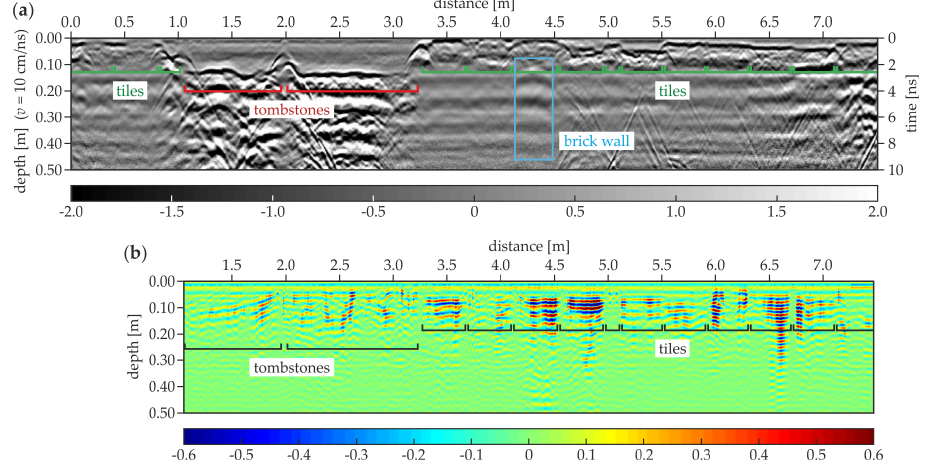
Figure 19. GPR and UT B ‐ scans for trace A ‐ 129 (south aisle): ( a ) GPR scan; ( b ) UT